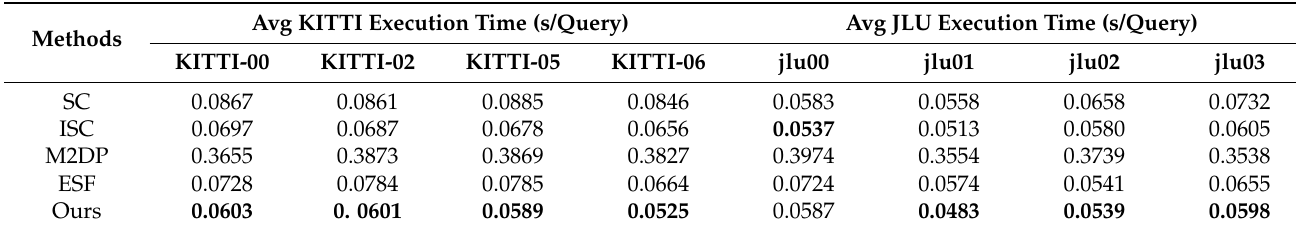
Table 2. Average execution time over KITTI odometry sequences and JLU datasets.